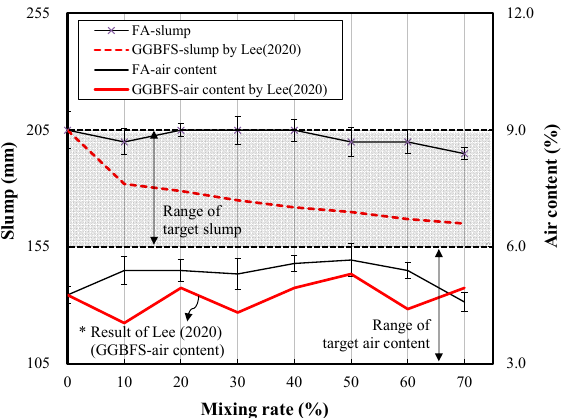
Figure 5. Results of the air content and slump values of OPC and FA compared with GGBFS as measured by Lee (adapted from [26]) in terms of the mixing rate.